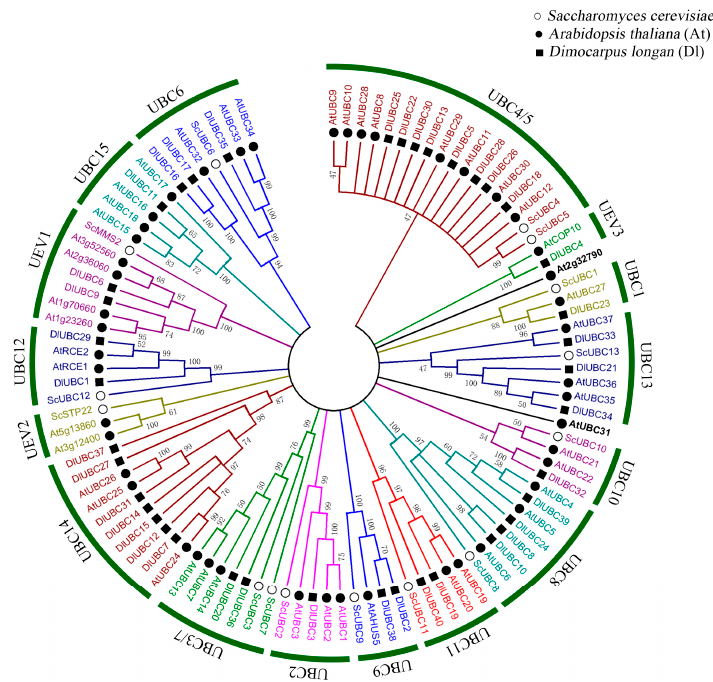
Figure 2. Phylogenetic analysis of the longan UBC proteins with orthologous members from Saccharomyces cerevisiae and Arabidopsis. The neighbor-joining (NJ) phylogenetic tree was constructed with MEGA 6.0 software. Different groups of DlUBC proteins are indicated by a circle and different colors.